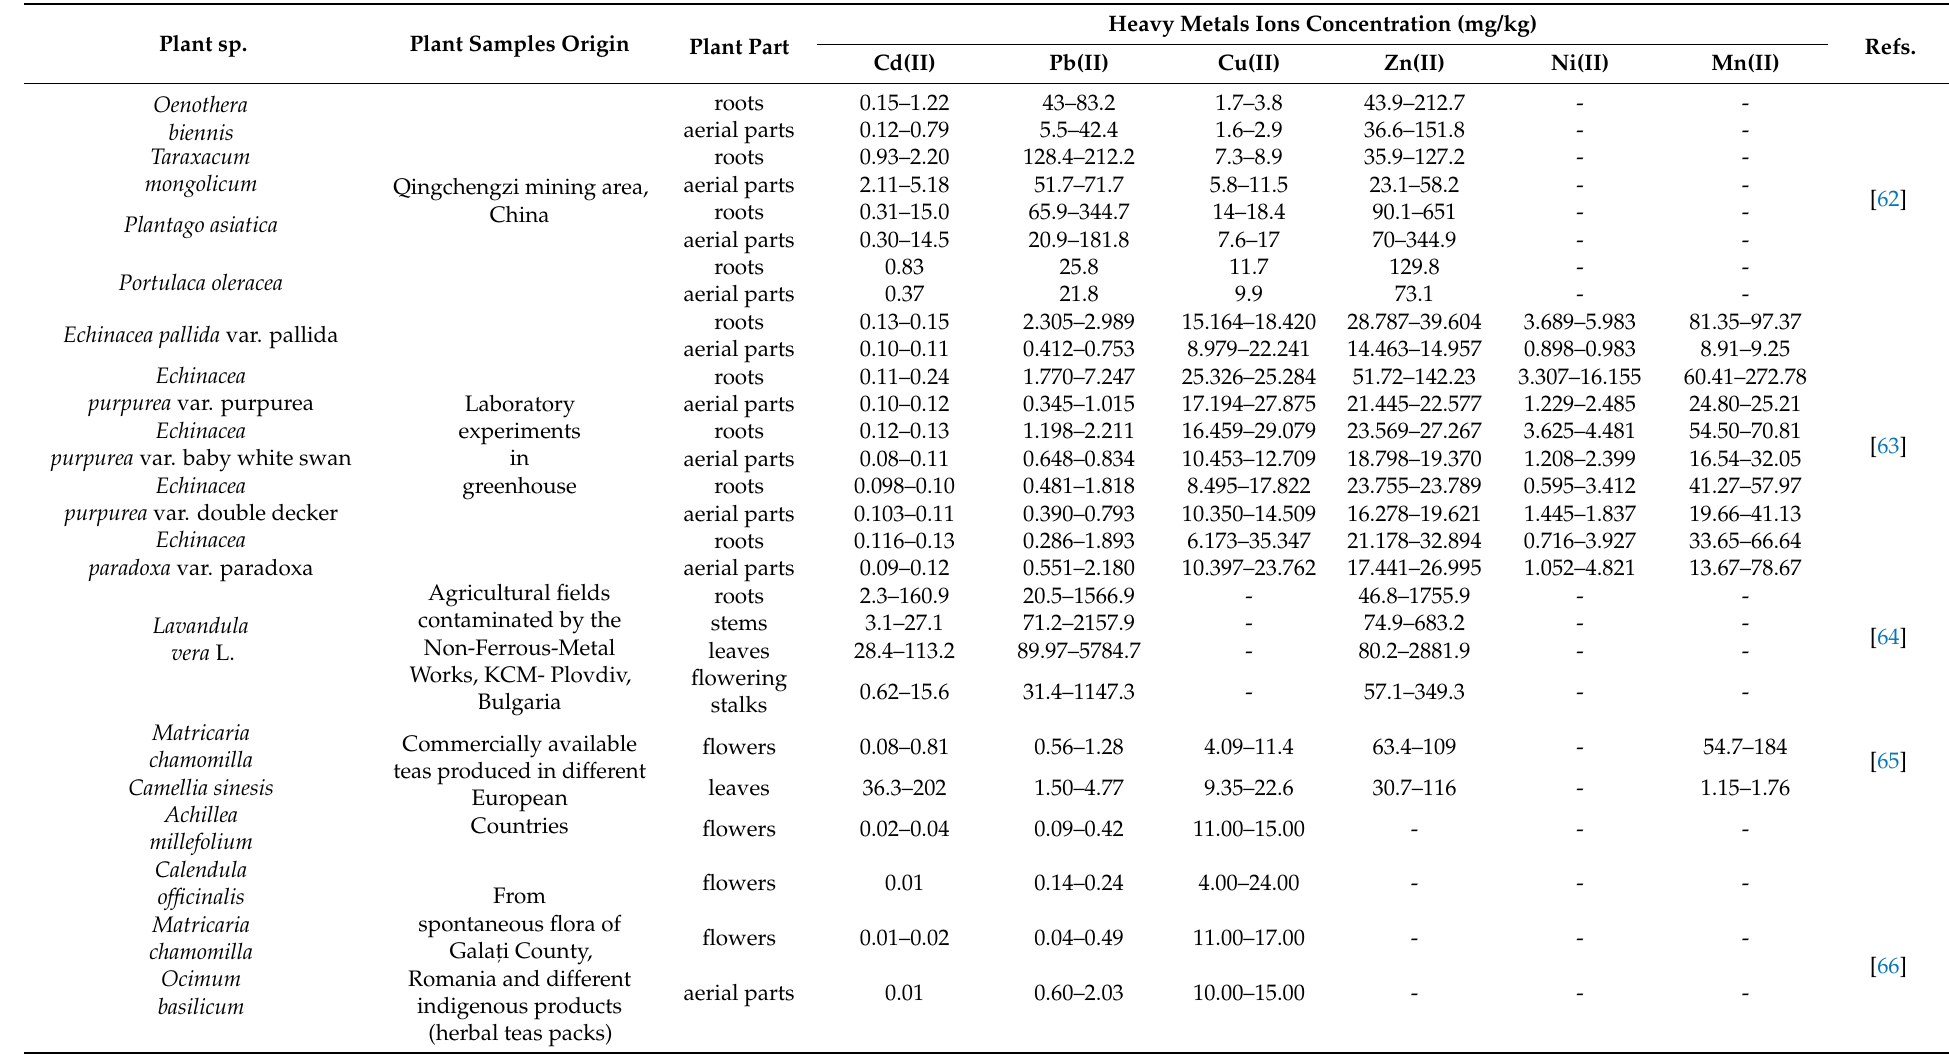
Table 1. Heavy metals contents in medicinal plants